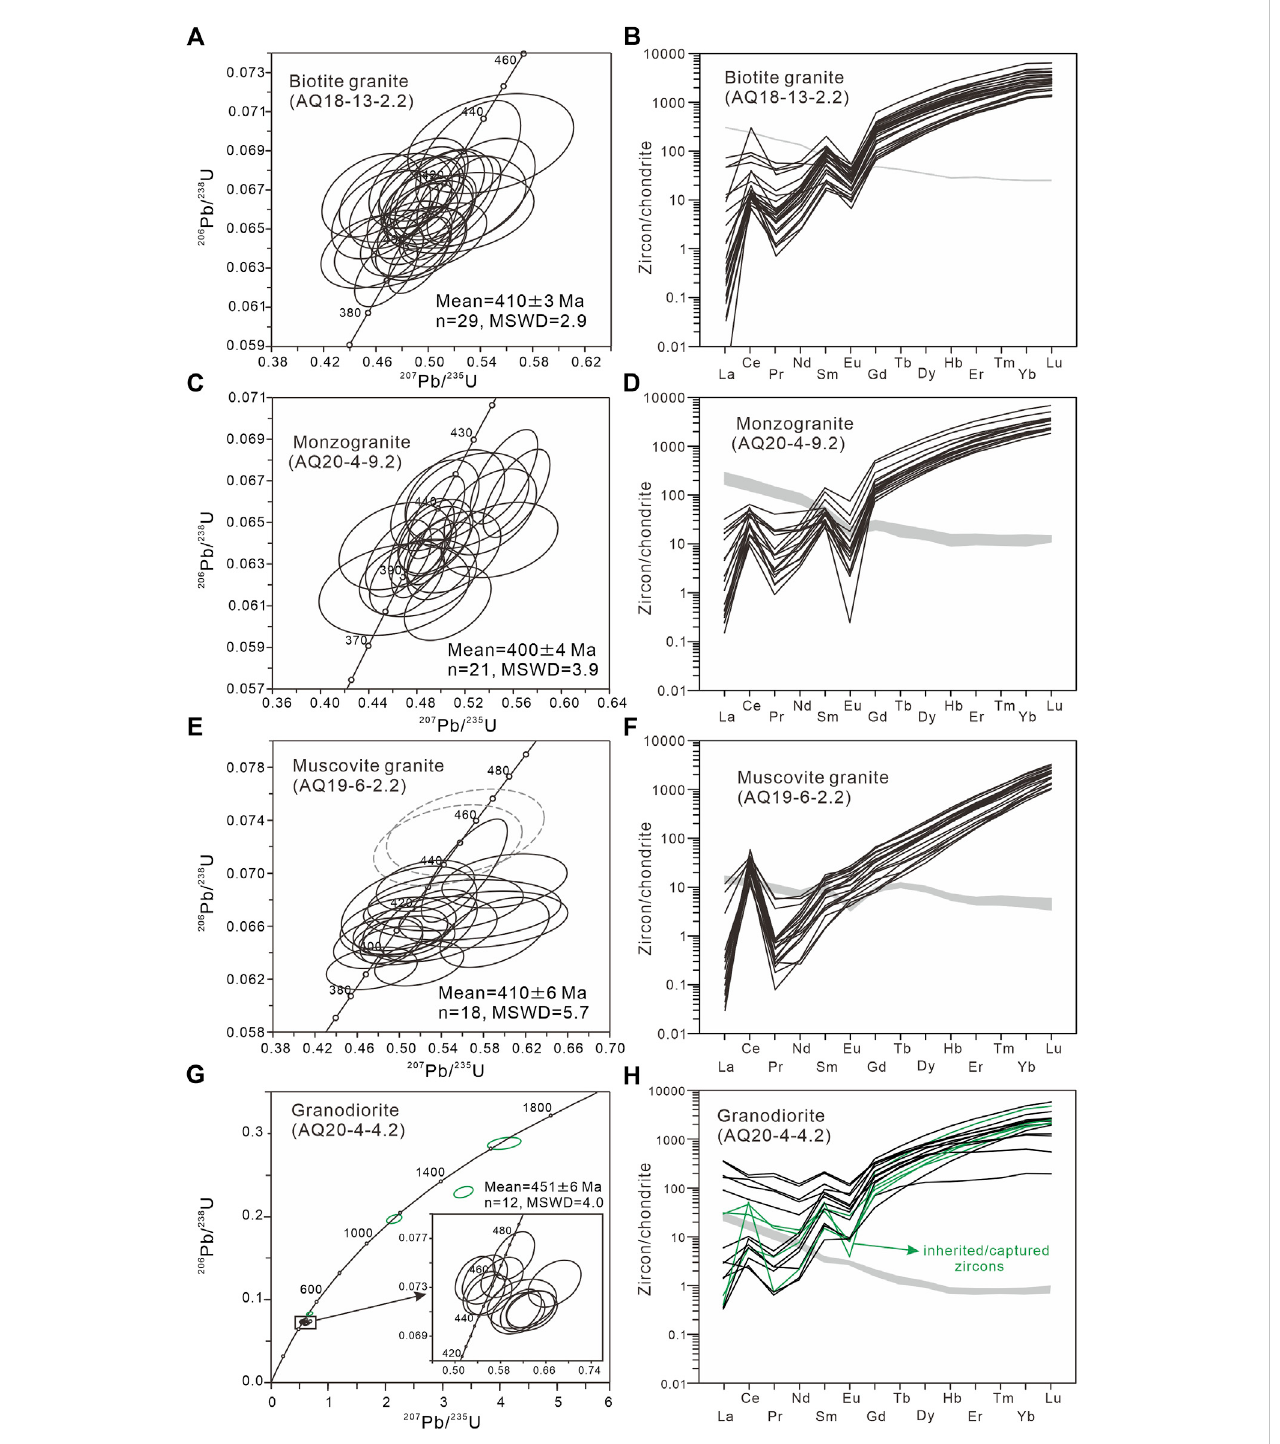
FIGURE 6 Zircon U-Pb concordia diagrams and chondrite-normalized REE diagrams for (A,B) biotite granite, (C,D) monzogranite, (E,F) muscovite granite, and (G,H) granodiorite in the Huatugou area. The whole-rock REE patterns in Figure 3A are gray-shaded